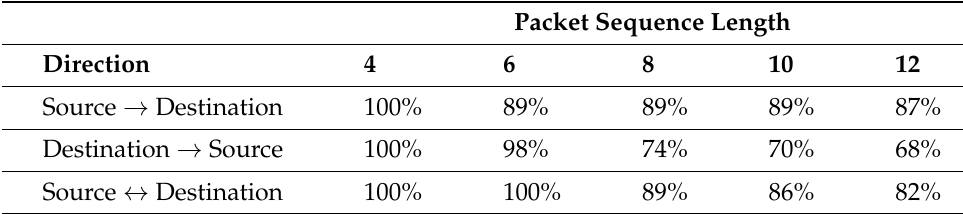
Table 5. Resulting true positive rate (TPR) of different types of signatures against the tested traffic. Signatures and tested traffic are part of the attack samples from the “Reconnaissance” category. The signatures are generated after a combination of packet direction and packet payload size.